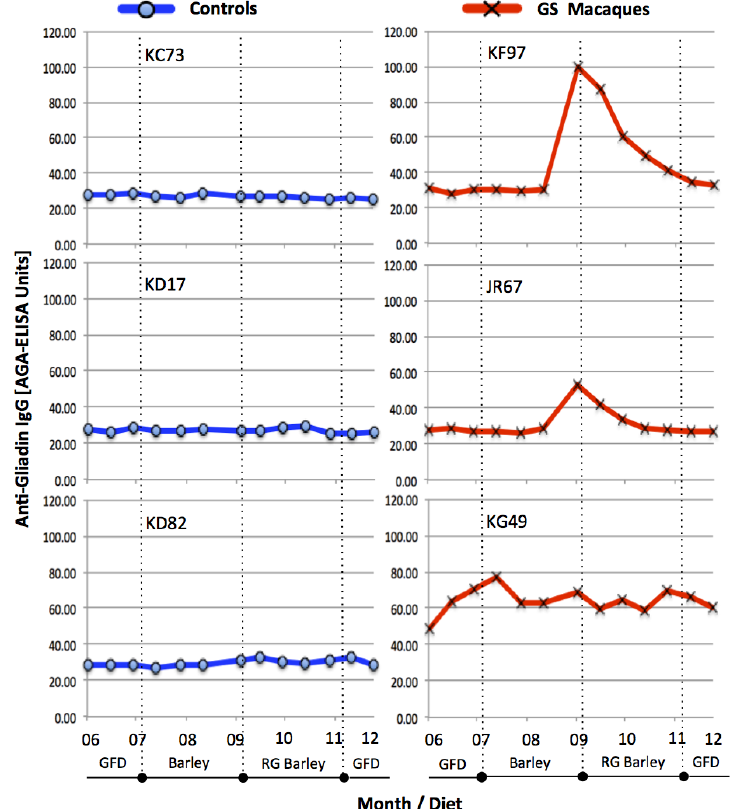
Figure 1. The kinetics of serum AGA antibody levels in three control (KC73, KD17 and KD82) and three GS (KF97, JR67 and KG49) macaques during the periods of (1) immunological remission e.g., GFD; (2) conventional barley diet; (3) RG barley diet and (4) GFD. Vertical, dotted lines indicate borders between different diets. Only the GS animals but not the healthy controls seroconverted to dietary gluten. The two GS macaques (KF97 and JR67) responded to its presence (AGA increase) as well as withdrawal (AGA decrease). KG49 macaque remained with elevated AGAs throughout the entire period of experiment regardless of dietary changes. AGA-ELISA cut-off = 40